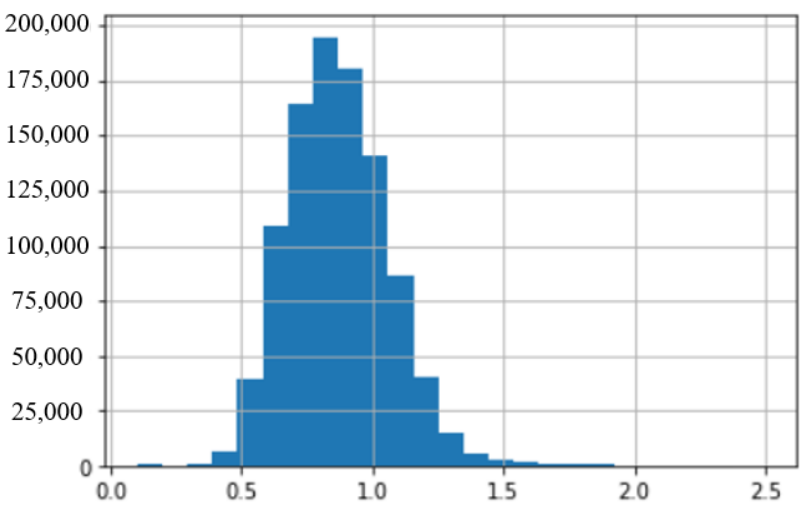
Figure 5. Distribution of Creatinine.